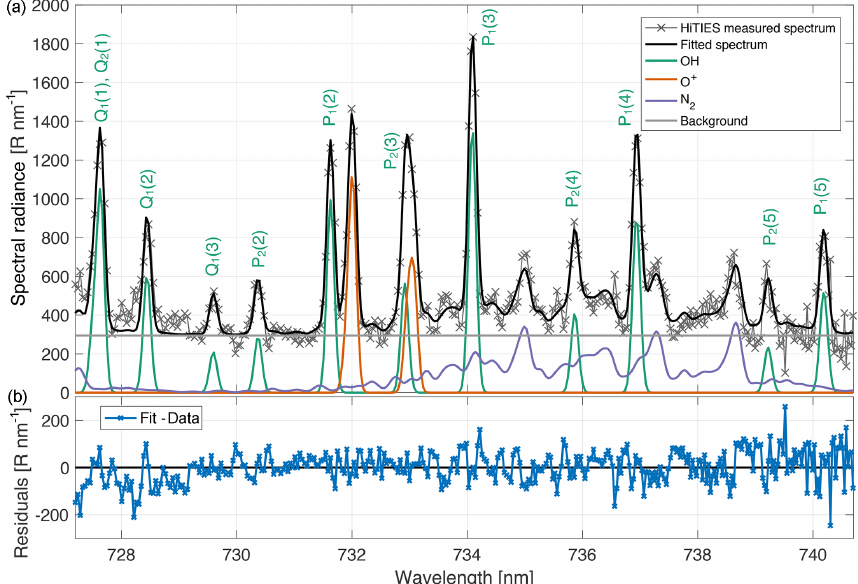
Figure 2. Example HiTIES spectrum during aurora and fitted components (a) . The data were taken on 15 December 2015 at 01:40UT with an integration period of 2min. The observed spectrum is plotted in light grey with crosses. The fit to the data using the fitting process described in Sect. 4 is shown in a thick black line. The coloured lines represent the components of the fit: OH lines in green, O + in orange, N 2 emission in purple, and the horizontal grey line is a constant background. Panel (b) shows residuals of the